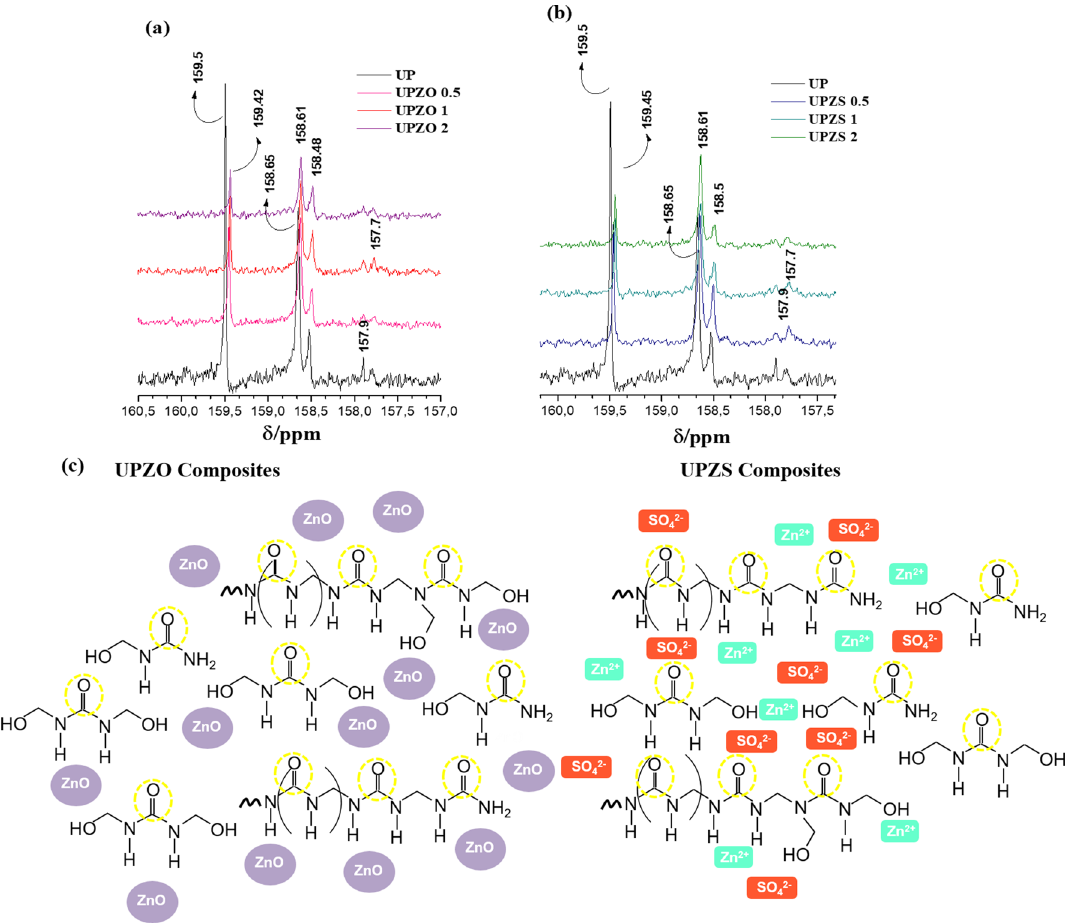
Figure 6. Amplification spectra of 13 C NMR 160–157 ppm of composites ( a ) UFZO and ( b ) UFZS solubilized in DMSO—d 6 and molecular structure proposed for the interaction of Zn particles with the polymers as well as the different medium of carbonyl groups. Molecular structure created using software Microsoft PowerPoint 2016 version.